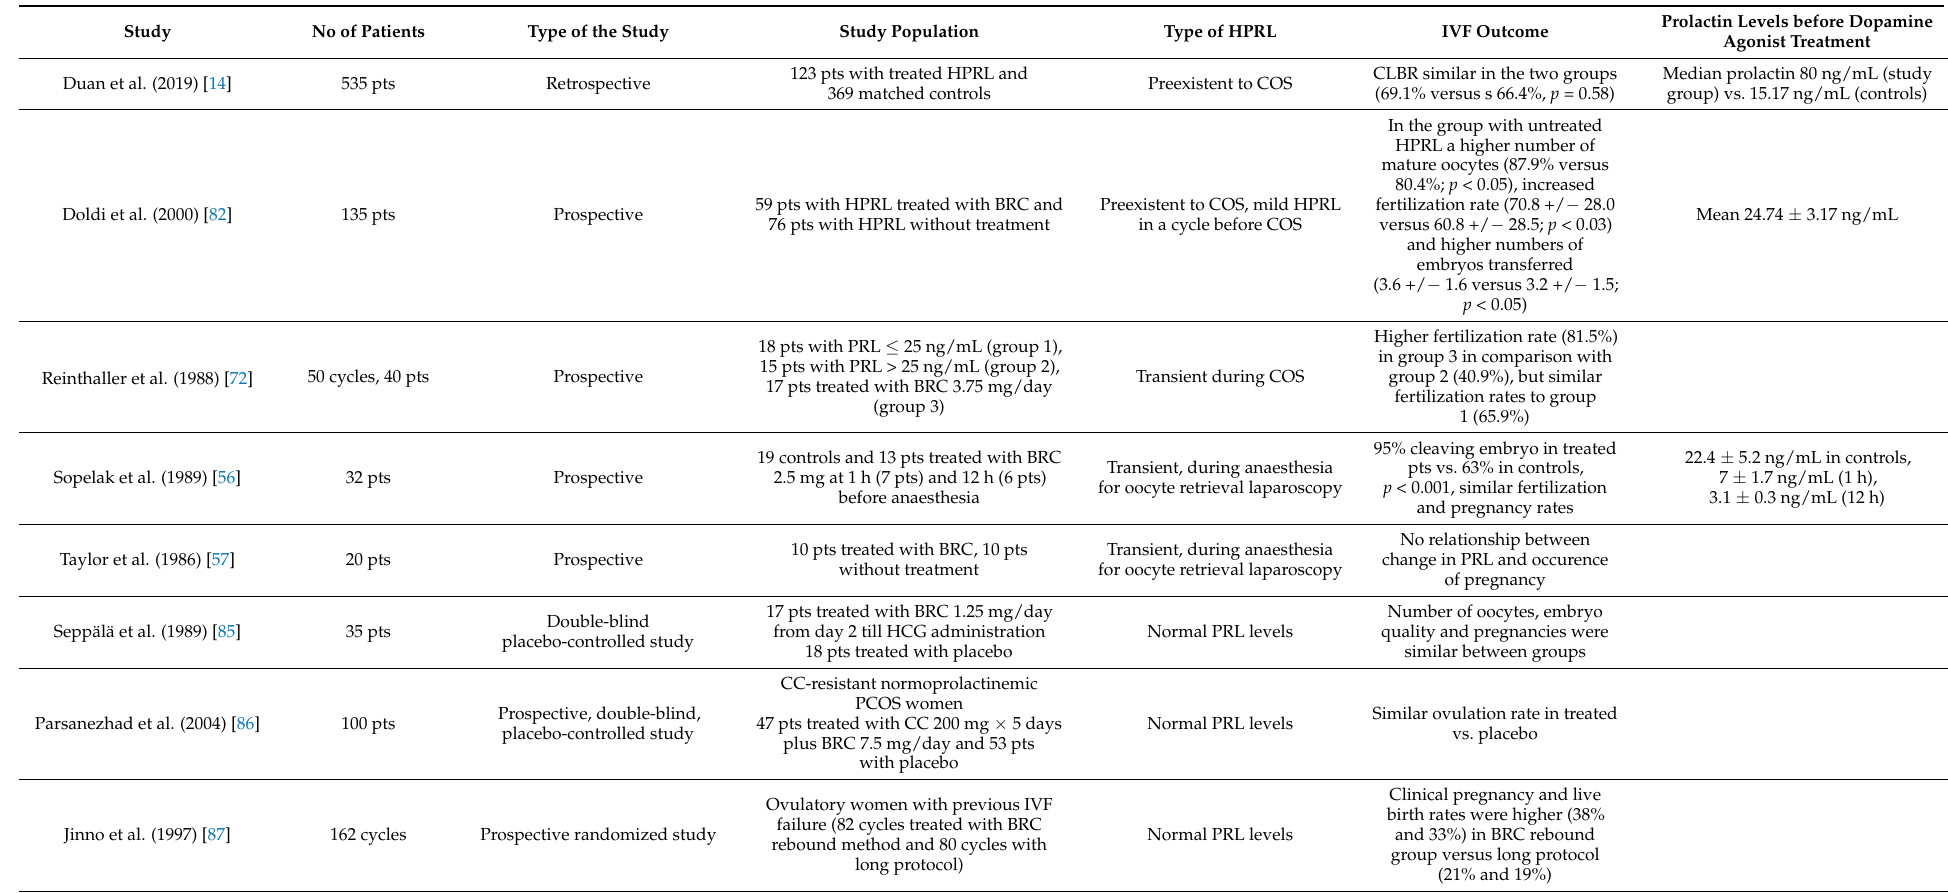
Table 1. Studies evaluating the efficacy of dopamine agonist administration on in vitro fertilization